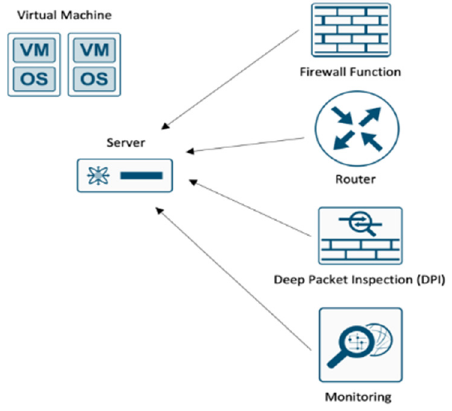
Figure 3. Network function